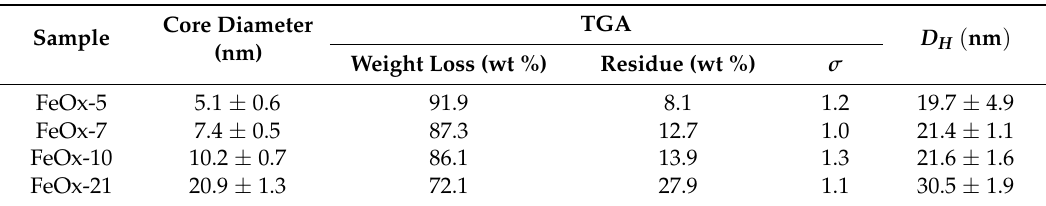
Figure 1. Preparation of the thermoresponsive core-shell iron oxide nanoparticles. Table 2. Characteristics of iron oxide nanoparticles grafted with poly(2-isopropyl-2-oxazoline) a molecular weight of 26 kg mol − 1 .